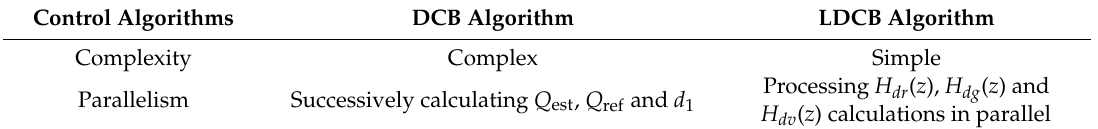
Table 1. Comparison between the conventional DCB and LDCB control algorithms.